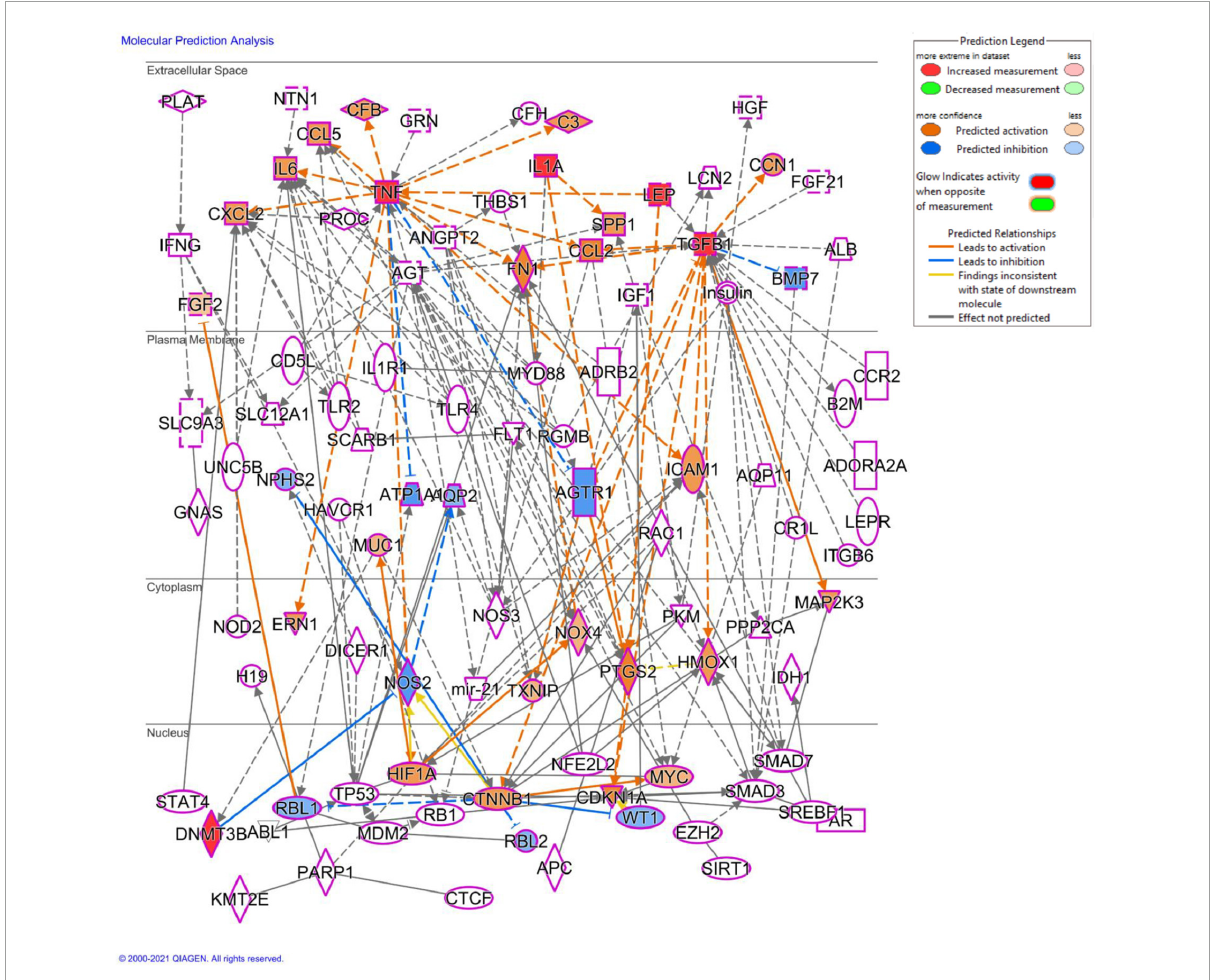
FIGURE13 Molecular prediction analysis using QIAGEN ingenuity pathway analysis (IPA) software. The molecular prediction tool shows the plausible mechanisms associated with the differentially expressed genes and cytokine, which will be used in our further study to determine the mechanistic basis of prenatal As exposure induced renal